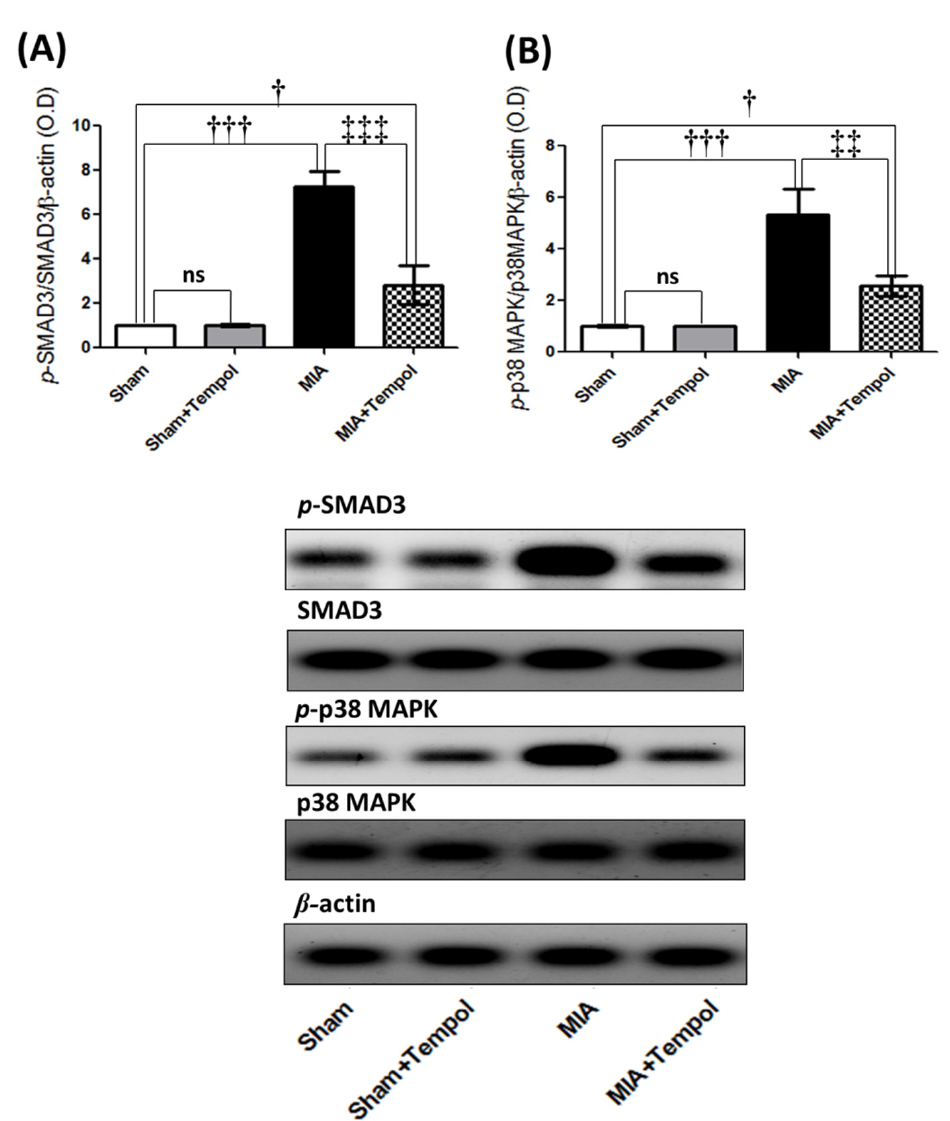
Figure 5. Effect of Tempol intracellular signaling of p-SMAD3 and p-p38MAPK on osteoarthiritic rats. Rats were subjected to a single intra-articular injection of 3 mg MIA/50 µ L saline in their right knees, and then tempol was administered starting from the 7th day of the experiment in a dose of (100 mg/kg/day) by oral gavage for 21 consecutive days. Values of ( A ) The protein expression of the phosphorylated small mother against decapentaplegic 3 homologs (p-SMAD3), and ( B ) The protein expression of phosphorylated p38 mitogen-activated protein kinase (p-p38MAPK). The cropped blots of p-SMAD3 and p-p38MAPK were presented relative to that of β -actin, and the uncropped images are available in the Supplementary File. Statistical analysis was carried out using one-way ANOVA followed by Tukey’s multiple comparison test. Results are expressed as mean ± SD ( n = 3). † p < 0.05 and ††† p < 0.001 vs. the sham group, and ‡‡ p < 0.01 and ‡‡‡ p < 0.001 vs. MIA group.